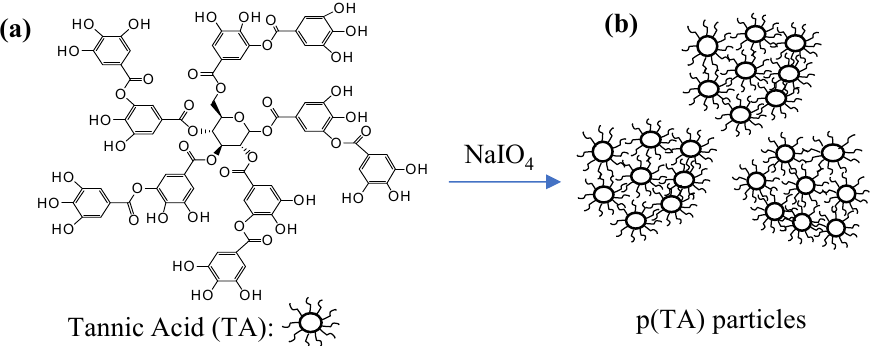
Tannic Acid (TA): Figure 1. Schematic representation of ( a ) poly(tannic acid) ( b ) ( p (TA)) particle preparation. The digital camera images of TA molecules and after formation of p (TA) particles in surfactant free media is given in Figure 2a,b, respectively. The discernible yellow color change to brown is the clear indication of particle formation. The optical microscope and SEM images, demonstrated in Figure 2c,d, respectively, further ascertain the p (TA) parti- cle formation. As can be clearly seen from the SEM images of p (TA) particles (Figure 2d), p (TA) particles are non-spherical (irregular, ellipsoidal). Moreover, additional SEM im- ages were given in Supplementary Figure S1 further corroborates the ellipsoidal shapes of the prepared p (TA) particles. Regardless of the used amounts of oxidizing agents, NaIO 4 , the obtained particles are almost about the same size with non-spherical shapes (SEM images are not shown). Figure 2. Digital camera image of ( a ) TA molecule, ( b ) p (TA) particles, ( c ) microscope image of p (TA) particles suspended in DI water, and ( d ) SEM image of p (TA) particles. In Table 1, the sizes of p (TA) particles prepared by using 50, 100, and 200 mole% NaIO 4 , were measured as 1582 ± 120, 1325 ± 116, and 981 ± 76 nm, respectively. As antici- pated, the higher the amounts of oxidizing agent, the smaller the size of p (TA) particles.